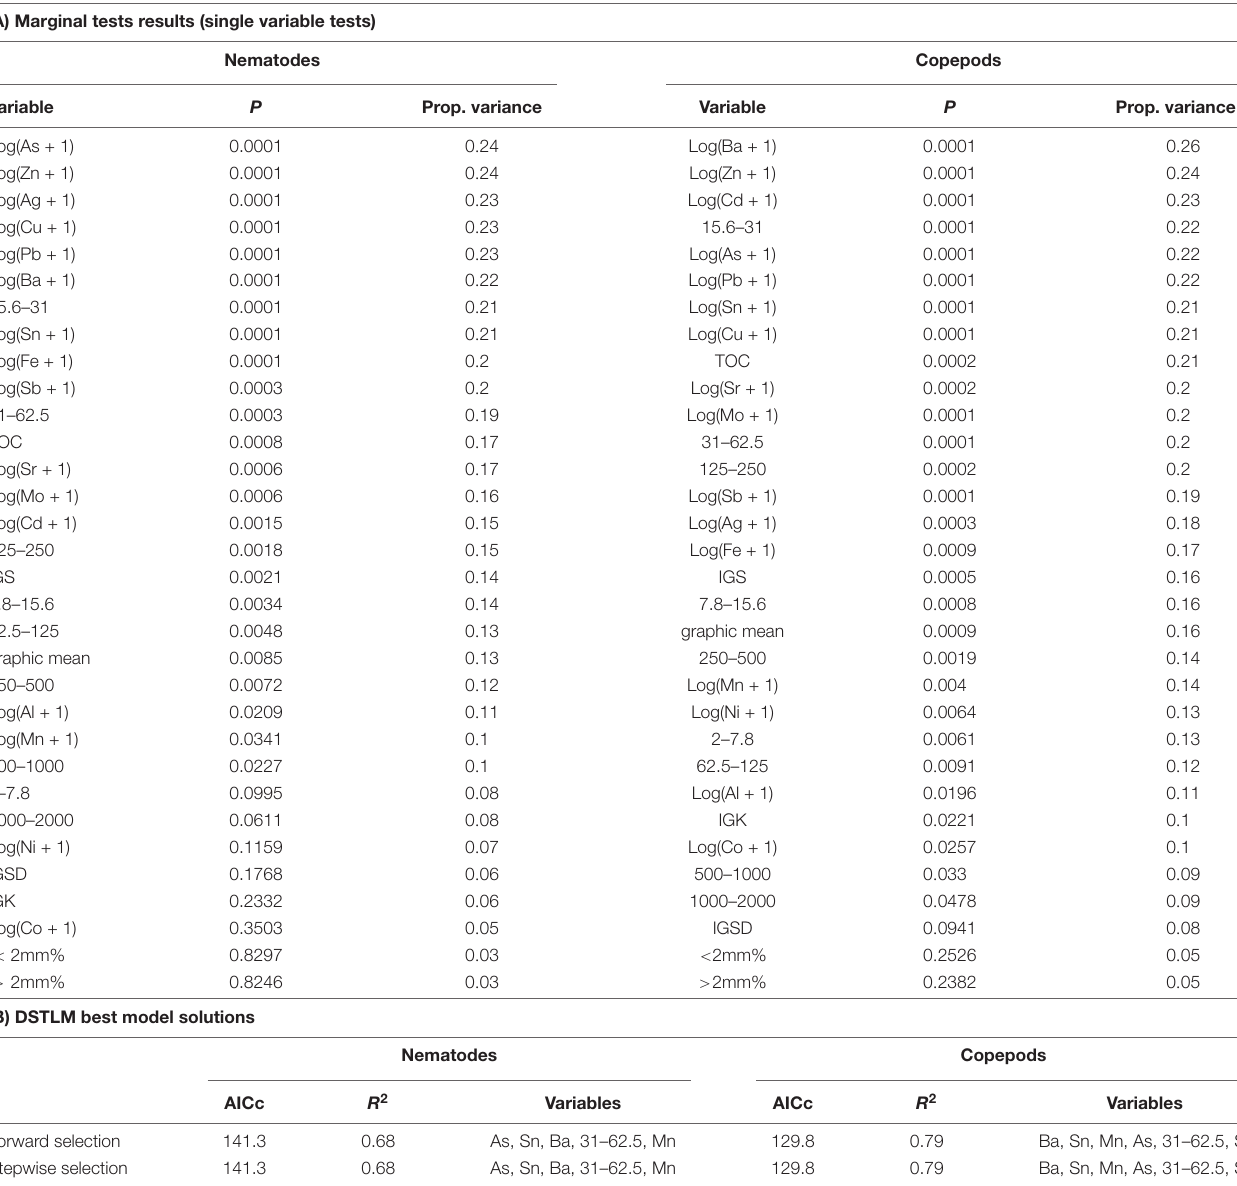
TABLE 8 | Results of distance-based linear modeling (DISTLM) of environmental variables against nematode and copepod communities. (A) Marginal tests results (single variable